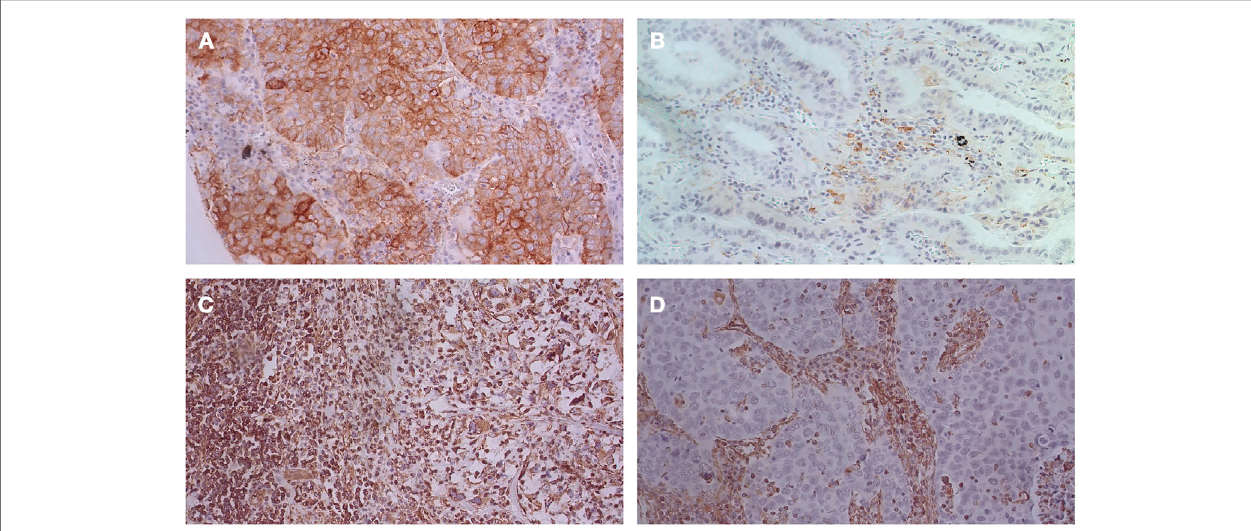
FIGURE 4 | IHC analysis for PD-L1 and vimentin: (A) PD-L1 positive in both tumor cells and in fi ltrate with immune cells (40X magni fi cation); (B) PD-L1 positive in in fi ltrate with immune cells, but negative in tumor cells (40X magni fi cation); (C) Vimentin expression observed both in tumor cells and immune cells (20X magni fi cation); (D) Vimentin expression observed only in immune cells (20X magni fi cation).